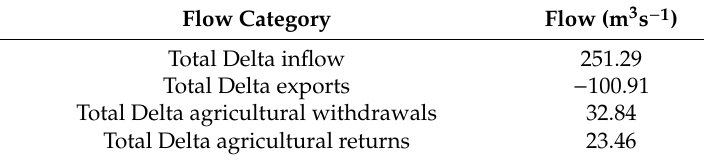
Table 1. Average observed flows during September 2014, immediately prior to isotope data